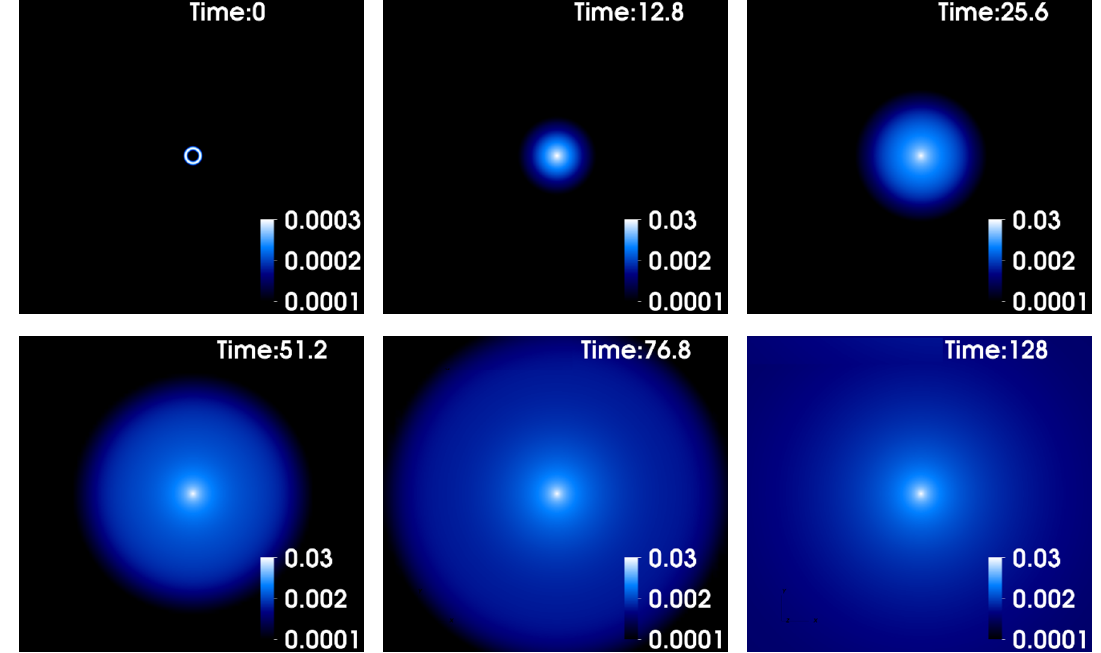
Figure 6 . Snapshots of the time evolution of the scalar (cid:12)eld pro(cid:12)le on the equatorial plane in the evolutions that do not impose spherical symmetry. One observes the initial RN con(cid:12)guration with a small dilaton perturbation evolving towards a dilatonic AAM BH.